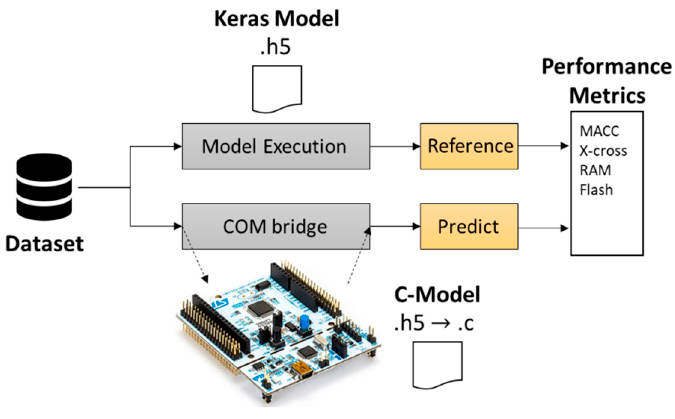
Figure 10. Validation on target flow by X-CUBE-AI.